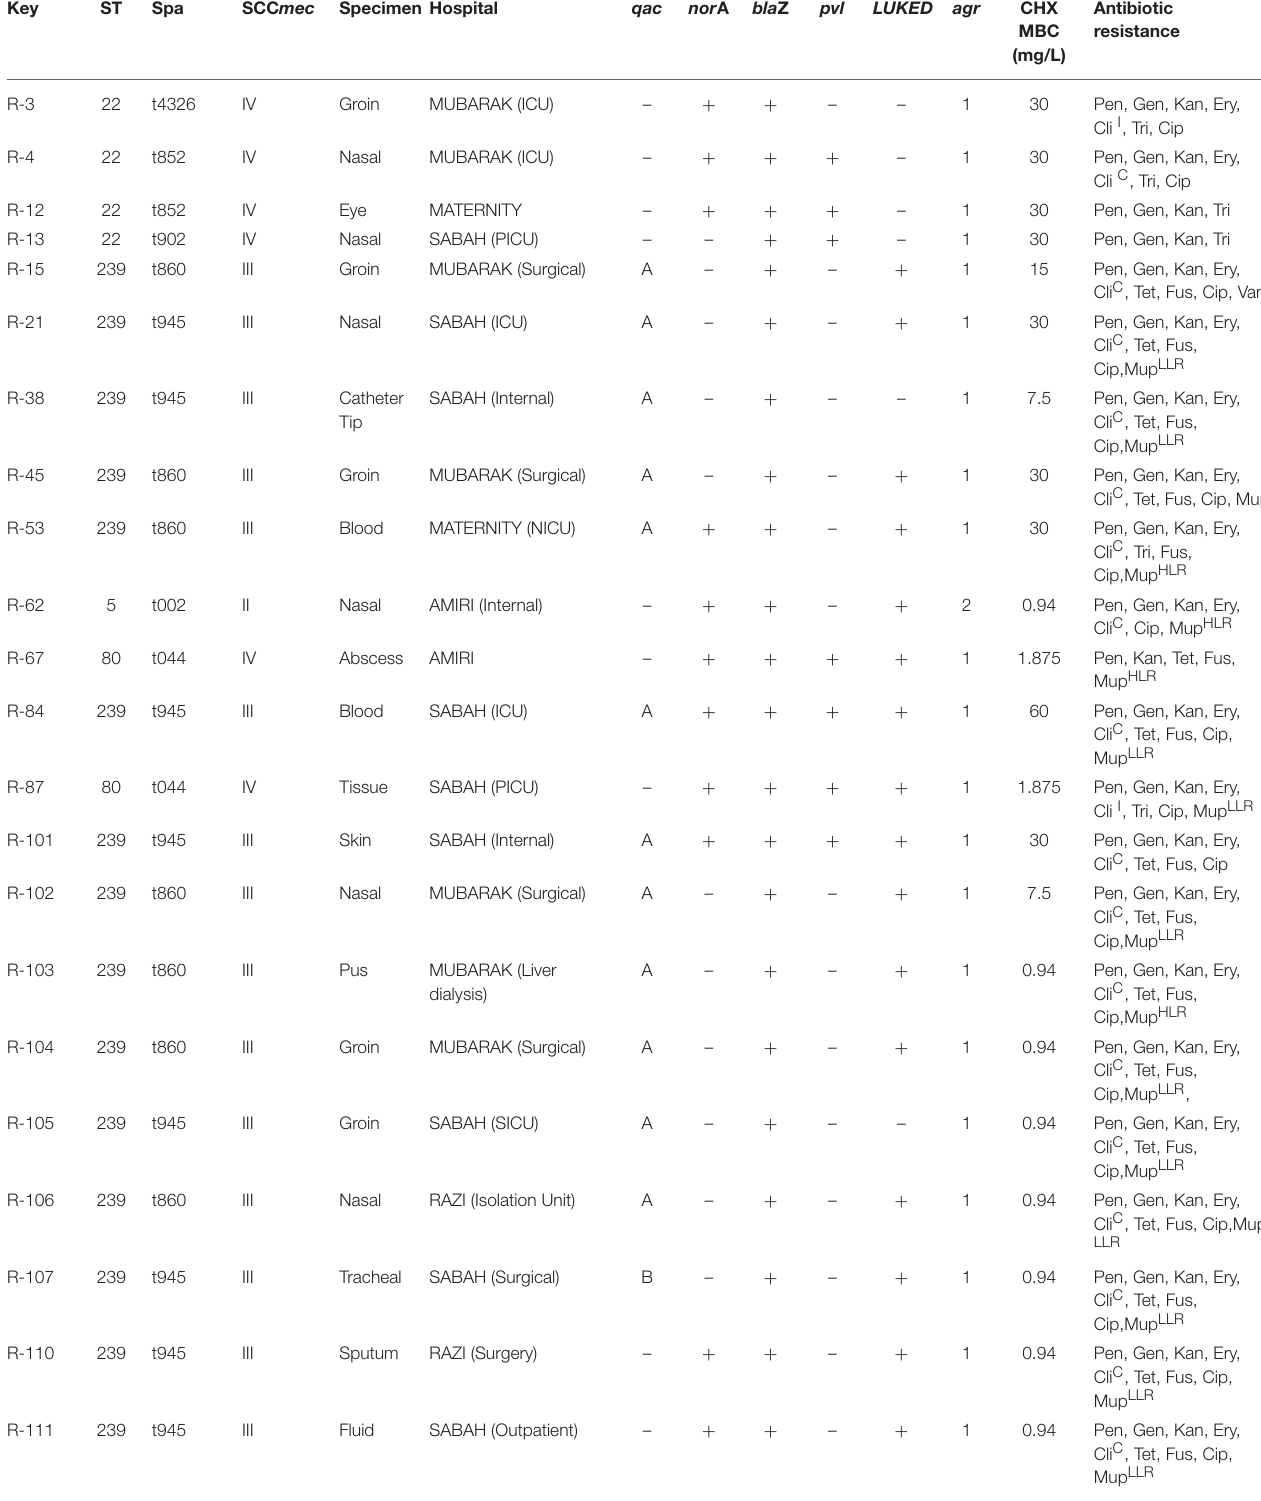
TABLE 4 | Typing characteristics and antimicrobial profile of qac( + ) MRSA and MSSA and qac(–) isolates with reduced susceptibility to chlorhexidine.